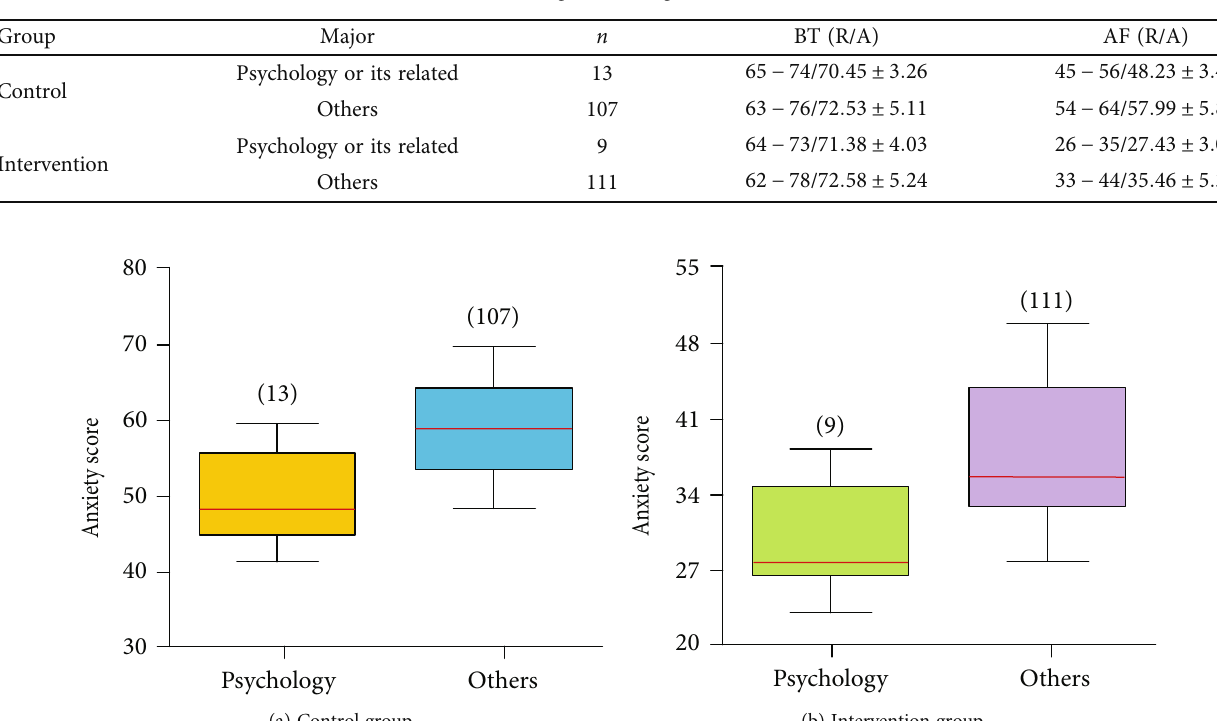
Table 5: Comparison of anxiety evaluation results of college students with di ff erent majors in the control and intervention groups before treatment (BT) and after treatment (AT) ( (cid:1) x ± s ). (Note: R: range; A: average).